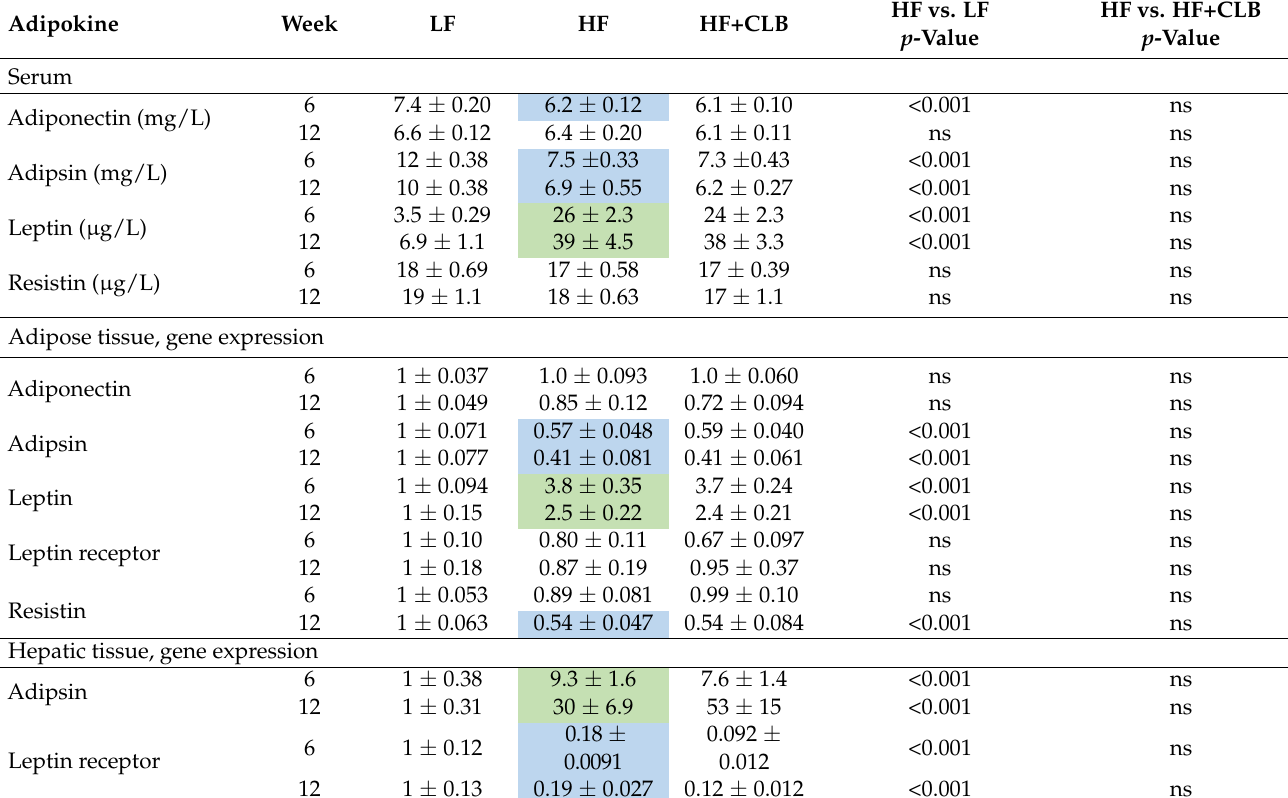
Table 3. Serum adipokine levels and adipokine expression in the epididymal fat pads and in the liver. Mice were divided into six groups to receive either a low-fat diet (10% of energy from fat, LF), high-fat diet (46% of energy from fat, HF), or cloudberry-supplemented high-fat diet (HF+CLB) for six or twelve weeks. The adipokine levels in the serum were measured by enzyme-linked immunosorbent assay (ELISA). The expression of adipokines and leptin receptor in the epididymal adipose tissue and in the liver was measured with RT-PCR and normalized to glyceraldehyde 3-phosphate dehydrogenase ( Gapdh ); mean expression levels in the LF group were set as 1, and the other values are given relative to that value. The data were analyzed with one-way ANOVA and Bonferroni post-test. The values represent mean ± SEM, n = 12 mice per group; ns = not significant ( p > 0.05). Blue color indicates a decrease in HF vs. LF group, and green color indicates an increase in HF vs. LF